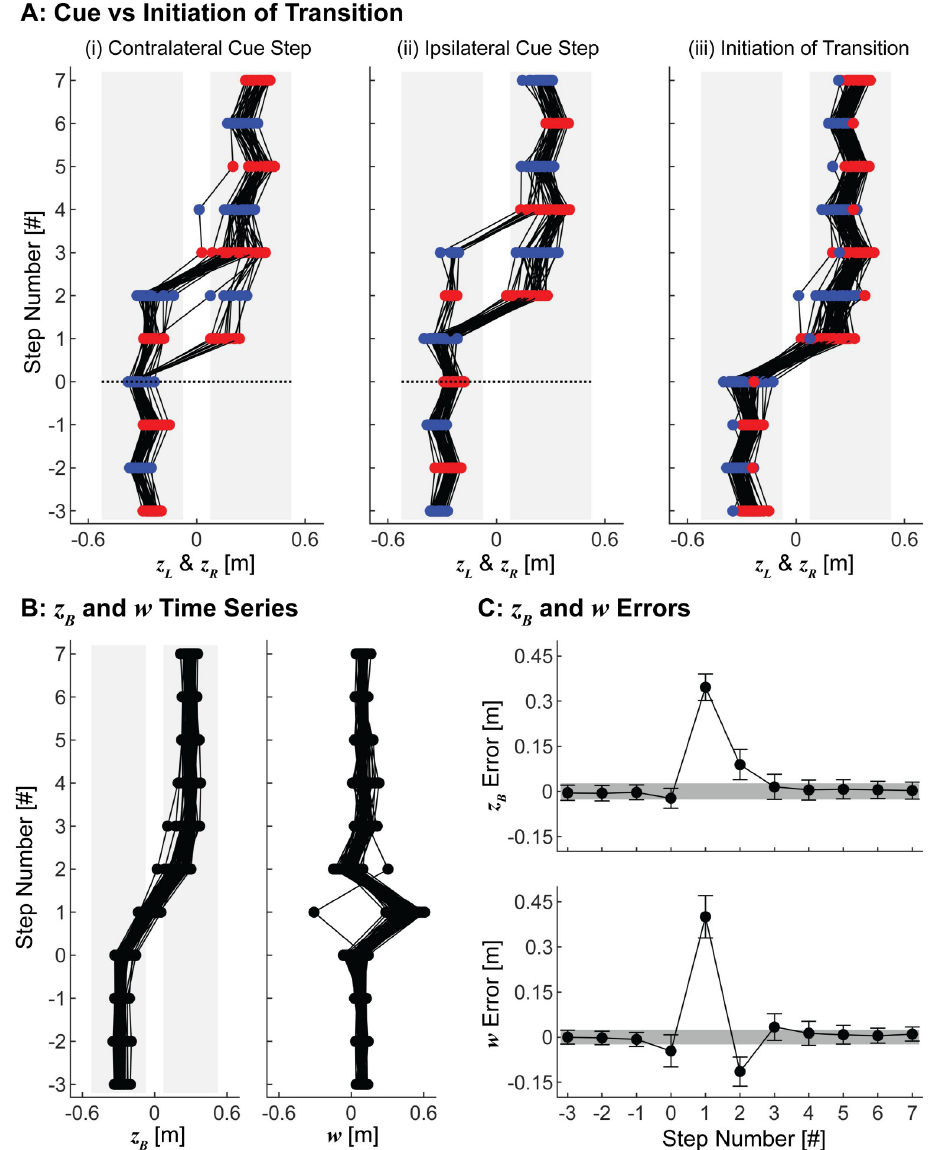
Fig 2. Experimental Stepping Time Series and Errors. A) Time series of left ( z placements for (i) 38 transitions when the cue was given on a contralateral step relative to the direction of transition, (ii) 41 transitions when the cue was given on an ipsilateral step relative to the direction of transition, and (iii) all 79 transitions with respect to the initiation of the transition, defined as the last step taken on the original path. In (i)-(ii), the black dotted lines at step 0 indicate the onset of the audible cue. All transitions are plotted to appear from left to right. B) Time series of lateral position ( z B ) and step width ( w ) for all transitions with respect to the initiation of the transition, with all transitions plotted to appear from left to right. C) Errors with respect to the stepping goals, [ z w � ]. For steps in the interval [–3, 0], z B � was defined as the experimental mean z B during steady state walking before the transition. For steps in the interval [1,7], z B � was defined as the experimental mean z B during steady state walking after the transition. For all steps analyzed, w � was defined as the experimental mean w during steady state walking. Error bars indicate experimental standard deviations at each step. Gray shaded regions indicate the mean ± 1 standard deviation from all steady state walking